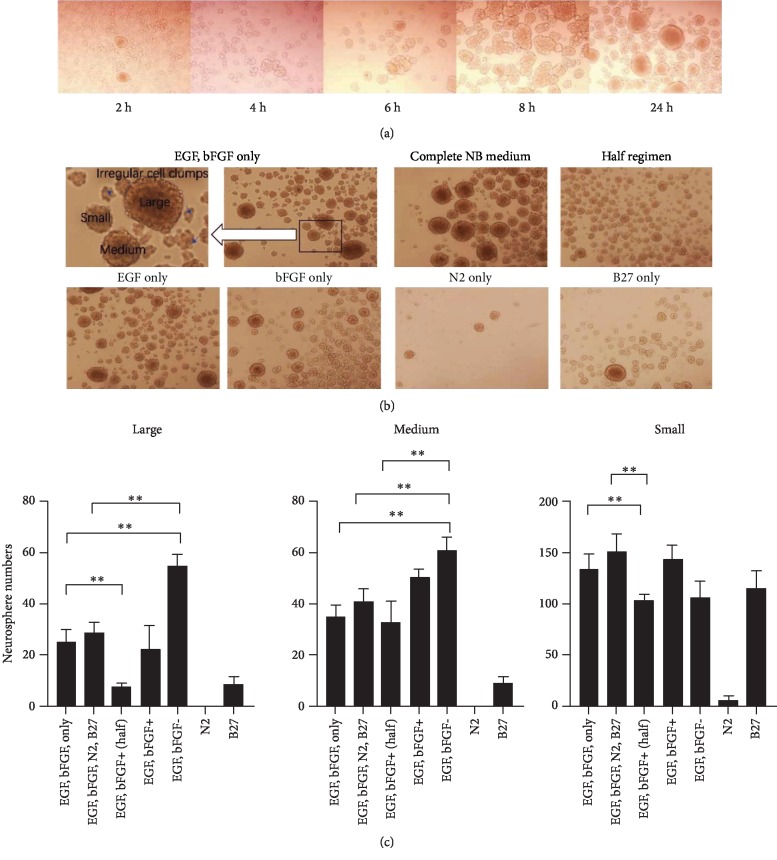
UC-MSC-derived neurospheres can be generated using one-step induction. (a) UC-MSC-derived neurosphere formation at different timepoints: 2 hours, 4 hours, 6 hours, 8 hours, and 24 hours after induction. (b) Representative phase contrast images (100x) of UC-MSC-derived neurospheres formed under different regimens, including (1) EGF, bFGF only regimen: EGF and bFGF, both at 20 ng/ml; (2) complete NB (neurobasal) medium regimen (EGF and bFGF, both at 20 ng/ml, with N2 and B27 supplements); (3) half regimen: EGF and bFGF, both at 10 ng/ml, with N2 and B27 supplements; (4) EGF only regimen: EGF 20 ng/ml, no bFGF, with N2 and B27 supplements; (5) bFGF only regimen: bFGF 20 ng/ml, no EGF, with N2 and B27 supplements; (6) N2 only regimen: DMEM/F12 with N2 supplement only, no EGF nor bFGF; and (7) B27 only regimen: DMEM/F12 with B27 supplement only, no EGF nor bFGF. Enlarged image of the black-boxed region denotes the arbitrary classification of large-, medium-, and small-sized neurospheres. Blue arrows denote irregular cell clumps. (c) Statistical analysis of large-, medium-, and small-sized neurospheres produced under different induction regimens. Neurospheres were scored in 6 random fields under the microscope at 100x magnification. n = 3. ∗∗p < 0.01.